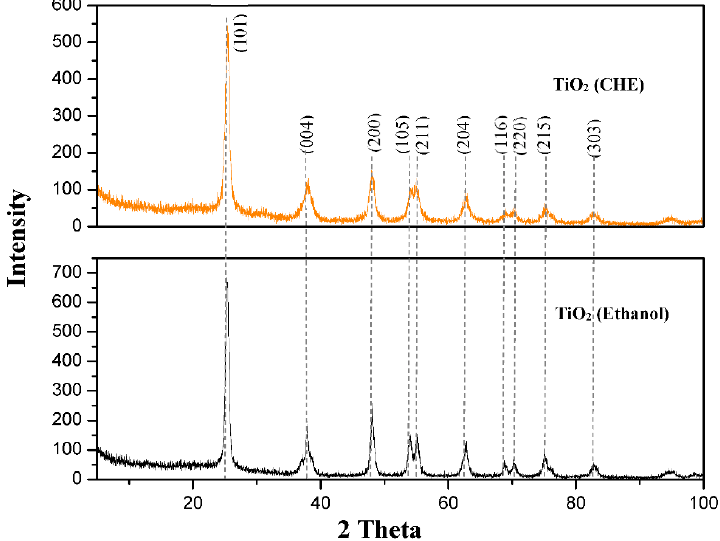
Figure 2. XRD patterns of the as synthesized nanomaterials.